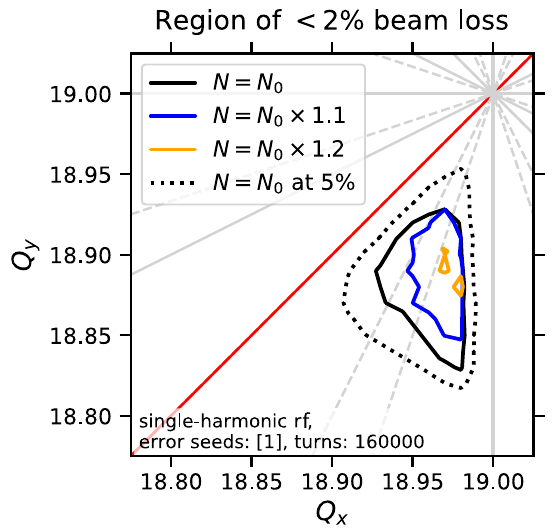
FIG. 12. Space charge limit for nominal operation. The solid contour lines enclose the tune area with less than 2% beam loss after the injection plateau for various beam intensities, obtained from FFSC simulations with the full field error model. The dotted contour line shows the reference 5% beam-loss threshold as in Fig.